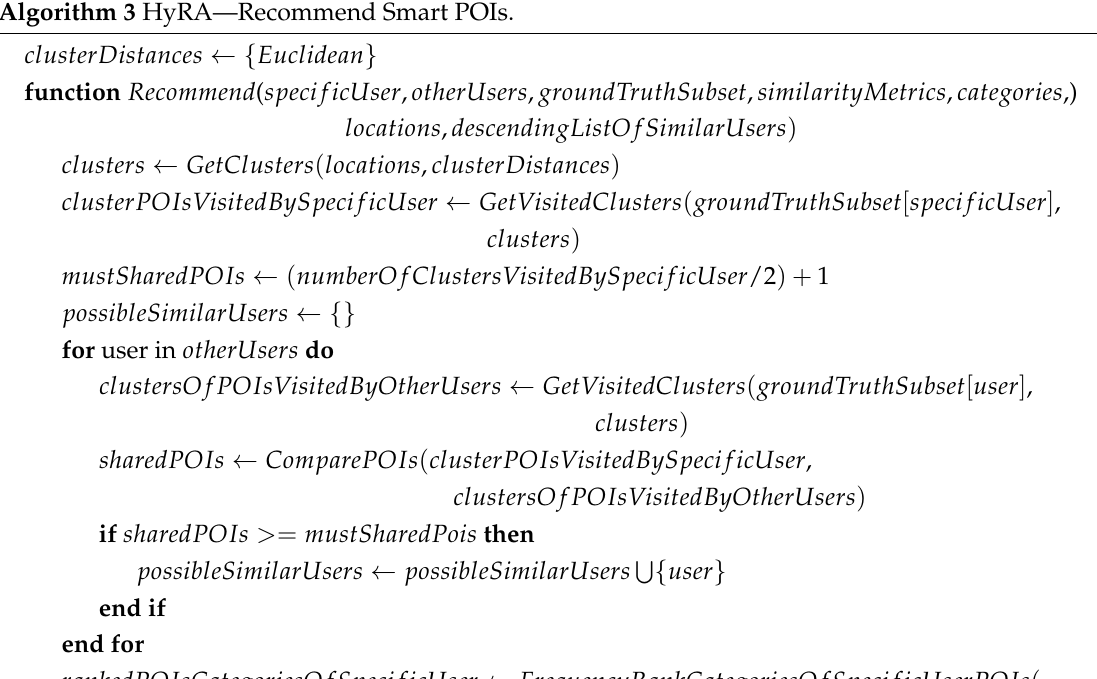
Algorithm 3 HyRA—Recommend Smart